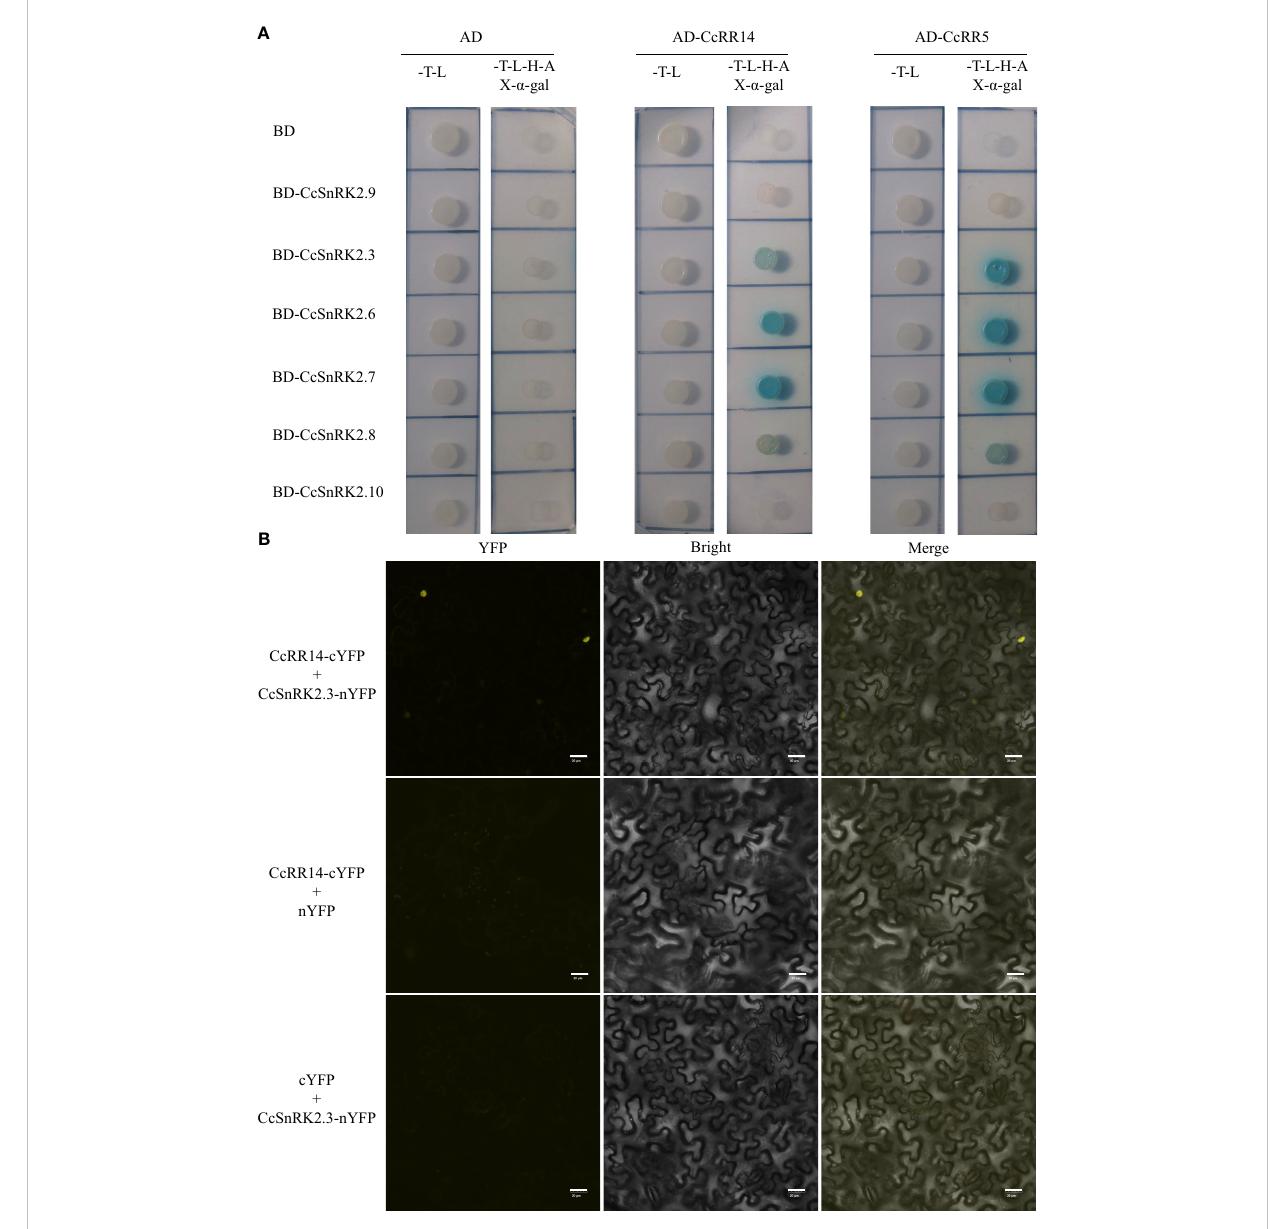
FIGURE 5 Interactions between CcRR5, CcRR14, and CcSnRK2s proteins. (A) Yeast two-hybrid assays between CcRR5, CcRR14, and CcSnRK2s. SD/-T-L, synthetic dropout medium lacking Trp and Leu. SD/-T-L-H-A, synthetic dropout medium lacking Trp, Leu, His, and Ade. (B) BiFC assays between CcRR14 and CcSnRK2.3. YFP, YFP fl uorescence; merge, merge of YFP fl uorescence; bright fi eld image. Bars = 20 µm.